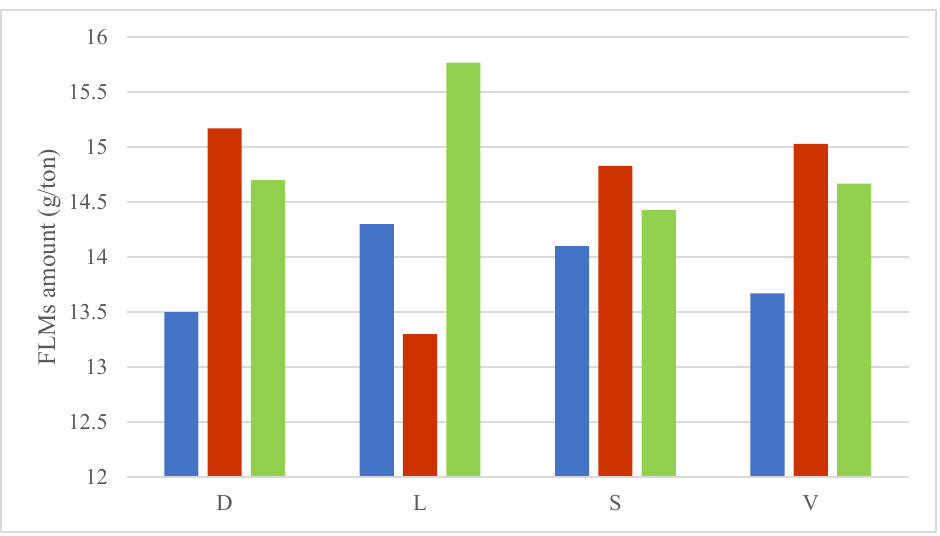
Table 4. Range analysis data.